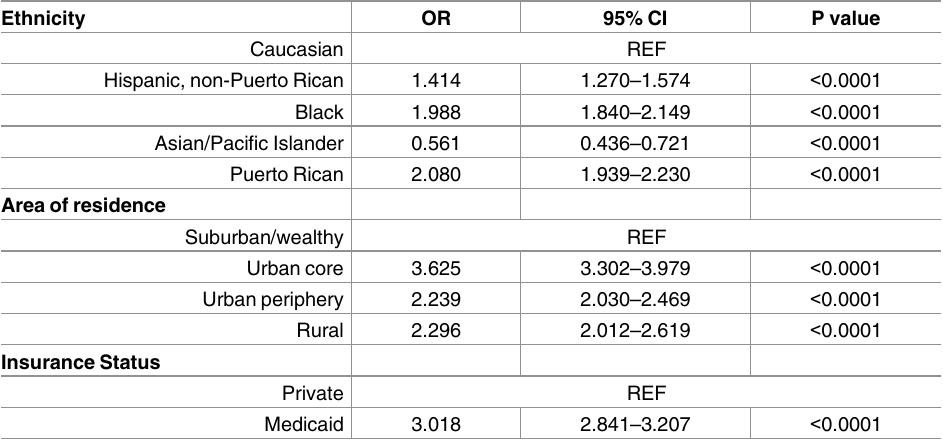
Values are unadjusted odds ratios (95% CI) relative to no SHS